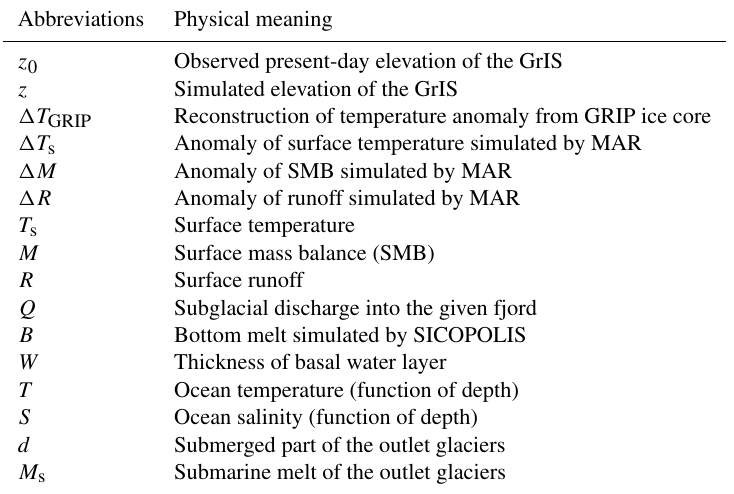
Table 1. Abbreviations in Fig.